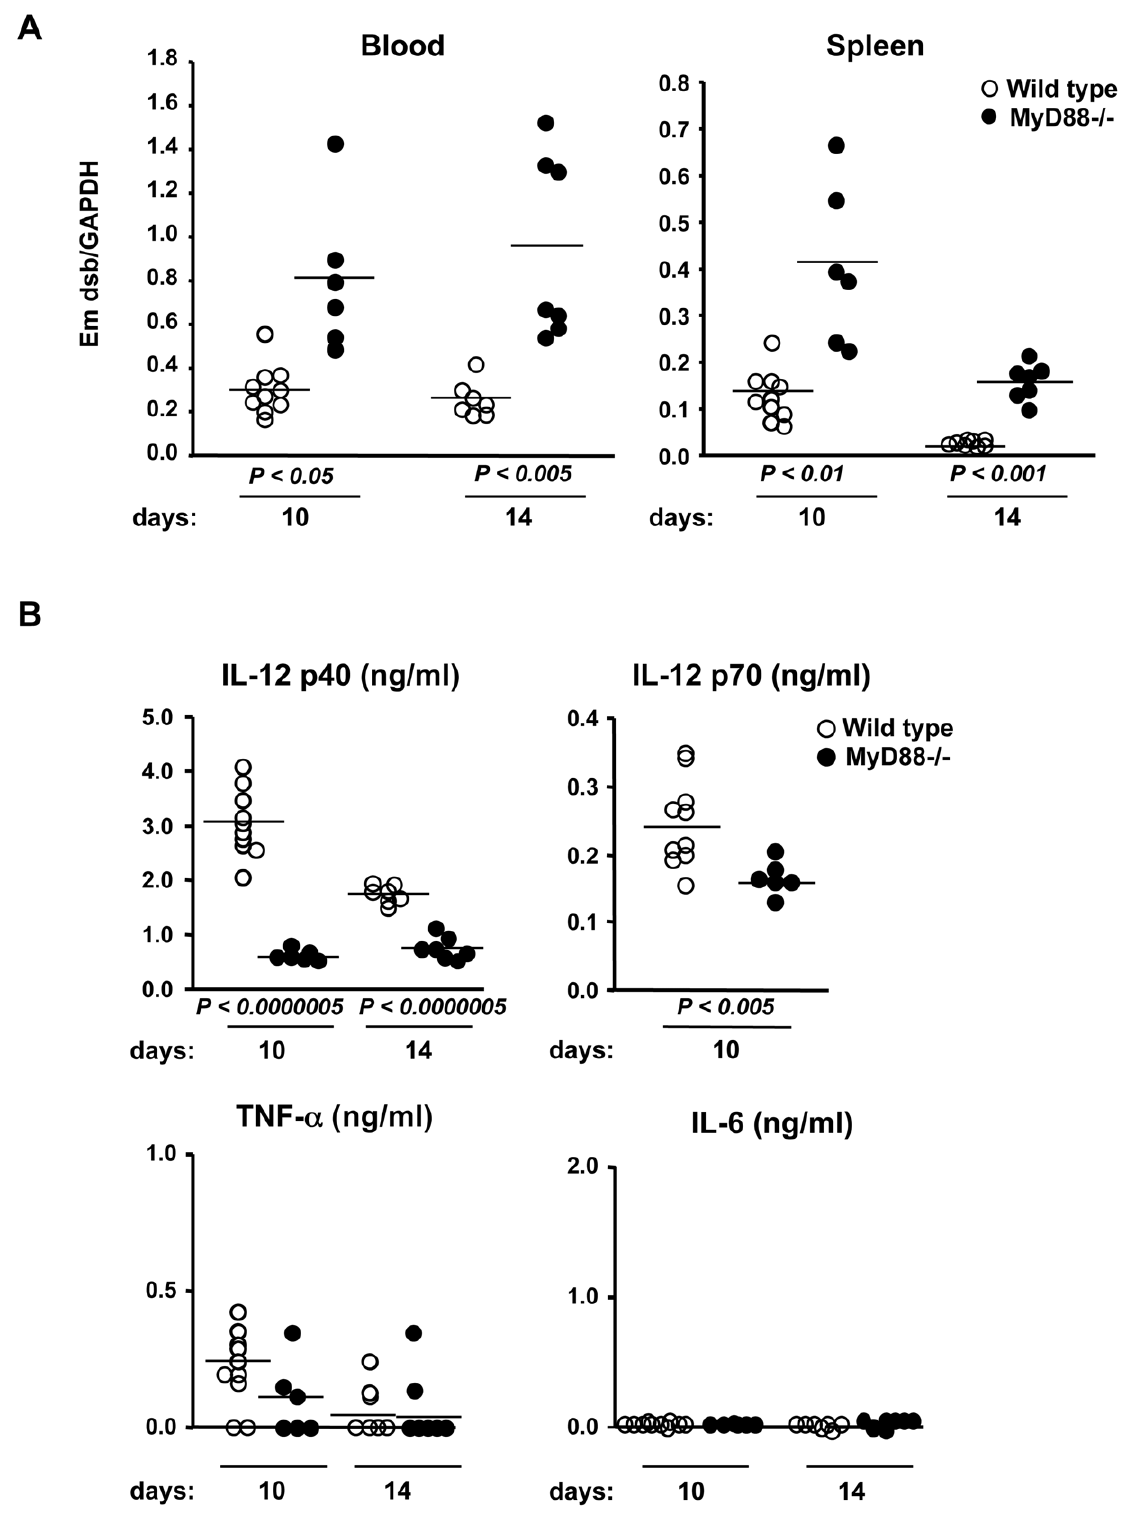
Figure 1. MyD88-deficient mice were susceptible to E.muris infection and demonstrated impaired IL-12 production invivo . Age and sex-matched wild-type ( n =10 at day 10, n =7 at day 14) and MyD88-deficient mice ( n =6 at day 10, n =7 at day 14) were infected with E. muris i.p. for 10 and 14 days. (A) E. muris loads in blood and spleen were quantified by qPCR using primers specific for the E. muris dsb gene. Data were normalized by qPCR data for the GAPDH gene in host genomic DNA. (B) Serum IL-12 p40, IL-12 p70, IL-6, and TNF- a levels from infected mice were assessed by ELISA. A single circle represents an individual animal, and lines indicate the mean values. The P -values were determined by Student’s t -test (Wild type vs. MyD88-/-). Data are representative of three independent experiments in A and B.